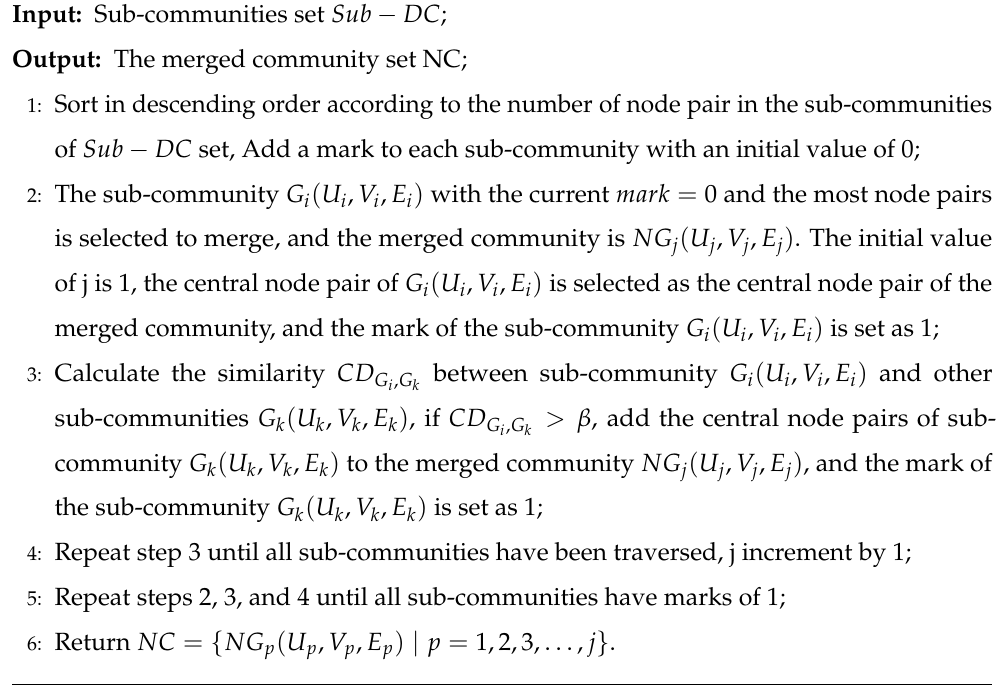
Algorithm 2 Use New Strategy To Merge